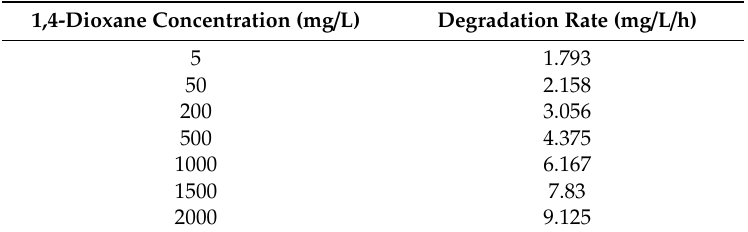
Table 2. Degradation rate at different initial concentrations of 1,4-dioxane.